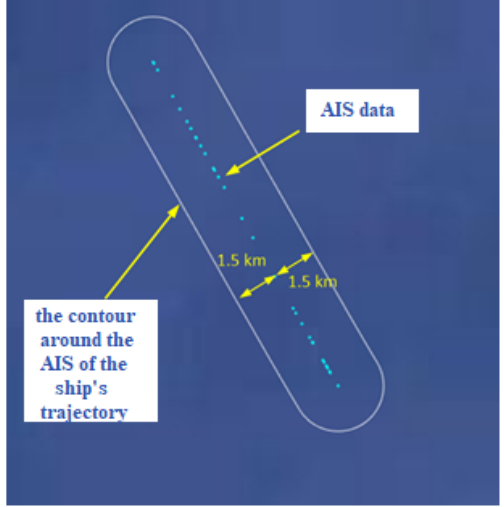
Figure 18. A contour formed around the AIS